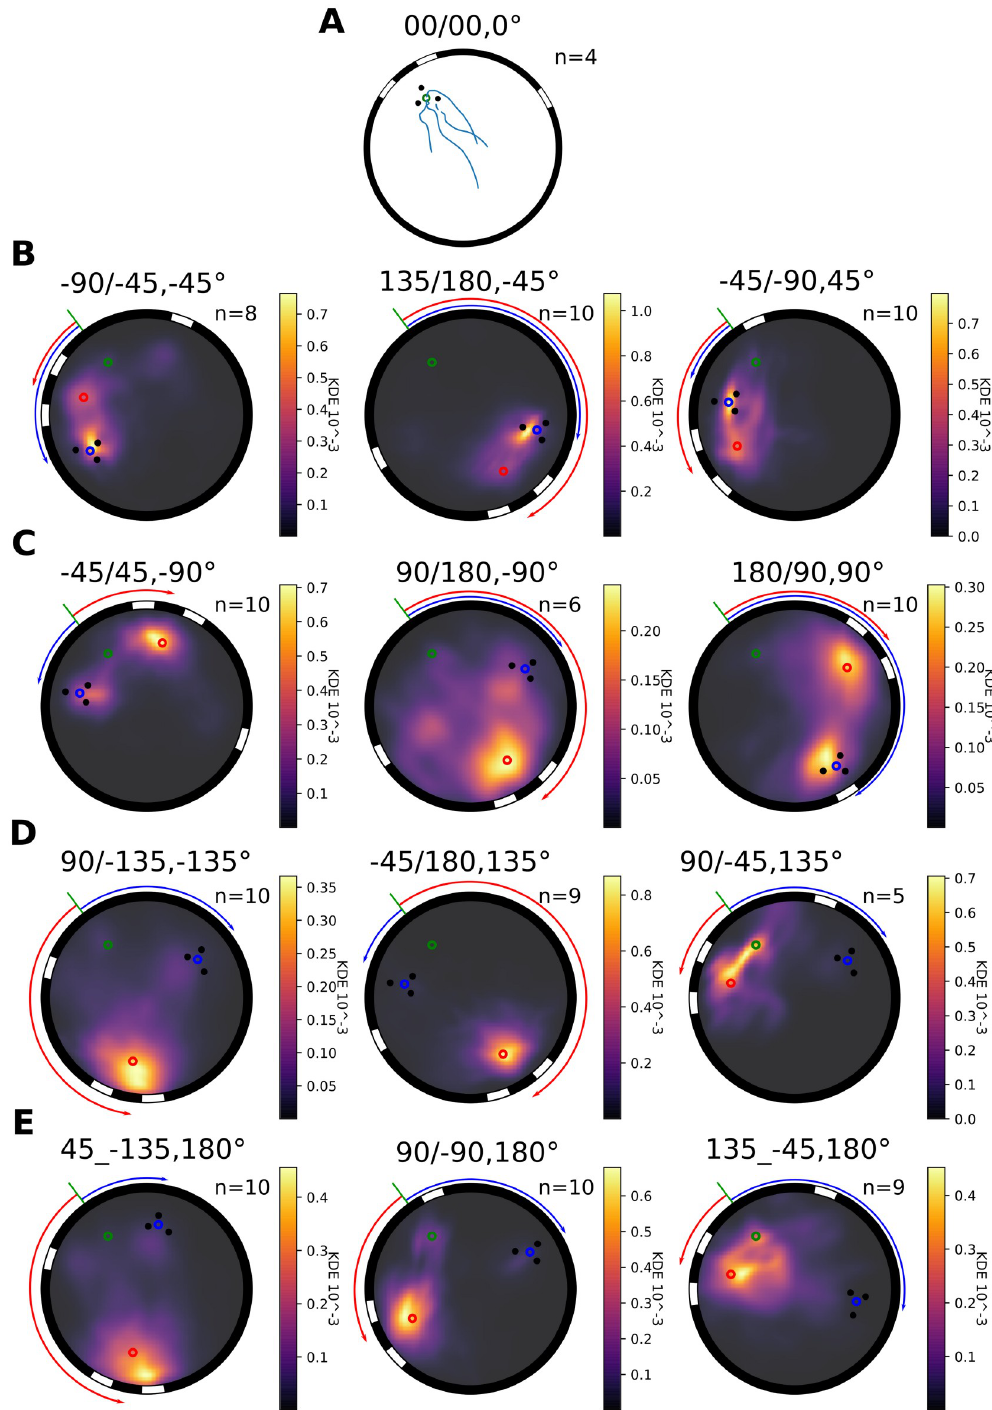
Fig 4. Probability distribution of bumblebees’ search location in the arena during conflict situations. Each subplot represents the arena with the different cues; the three stripes and the three cylinders, and the corresponding fictive nest entrance; red and blue. The real nest hole is represented by a green dot. Rotations inflicted to the different cue-constellations are represented by an arrow of the corresponding colour. A: the trajectories of bumblebees during non-conflict situation (n = 4). For all the other subplots, the colourmap represents the normalized KDE of the flights distribution from low density (black) to higher (yellow). The number of flights in each condition is indicated in the corresponding sub-figures. Each